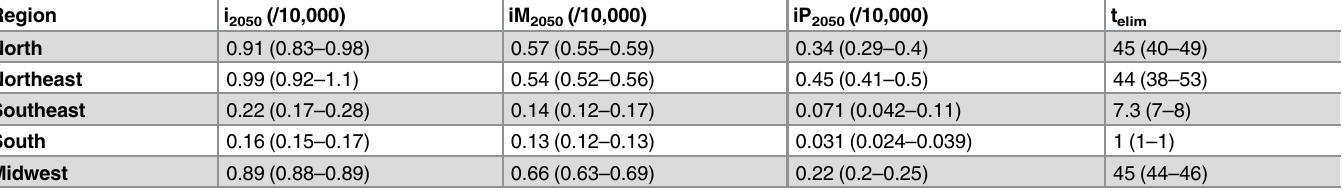
Table 3. Posterior predictions (mean and range) from the regional model for Hansen ’ s Disease fit to regional data from Brazil. Incidence of Han- sen ’ s Disease in the year 2050 is reported overall (i 2050 ) and for multibacillary (iM 2050 ) and paucibacillary (iP 2050 ). The time to elimination (t elim ) was calculated as the year in which overall incidence was (cid:4) 1/10,000, starting from 2001.